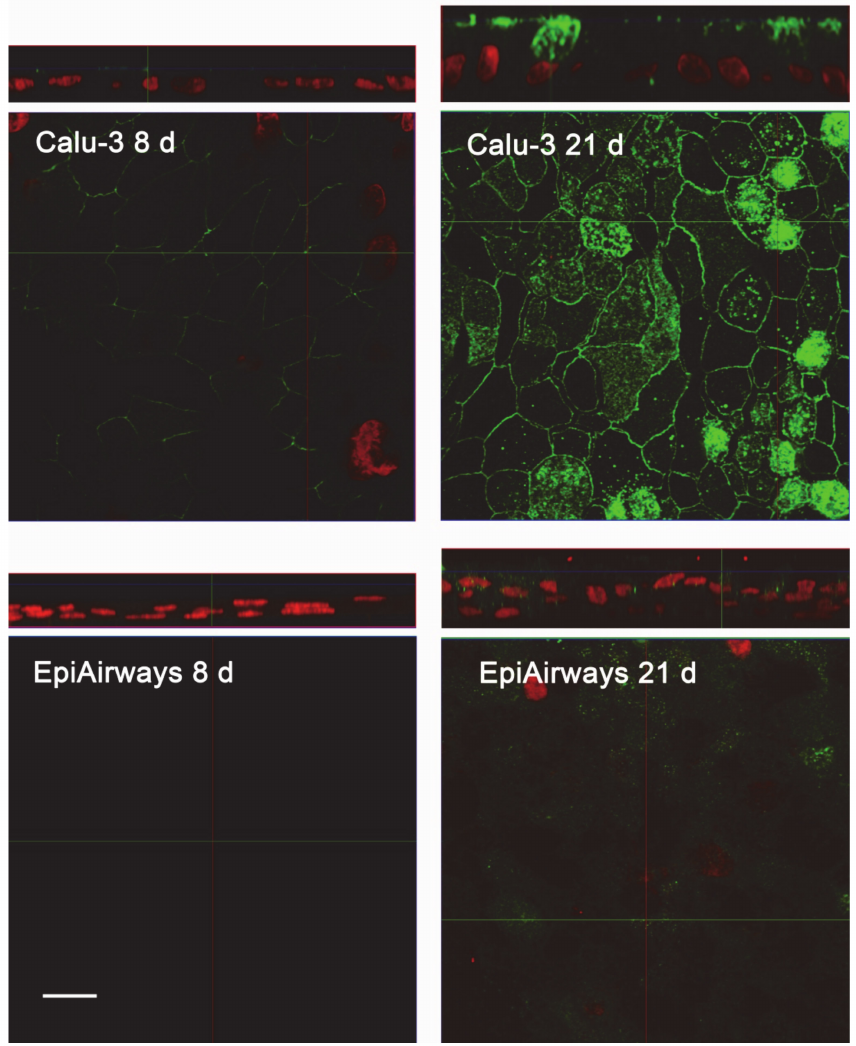
Figure 4. Immunocytochemical analysis of MDR1 expression in Calu-3 cells and EpiArway ™